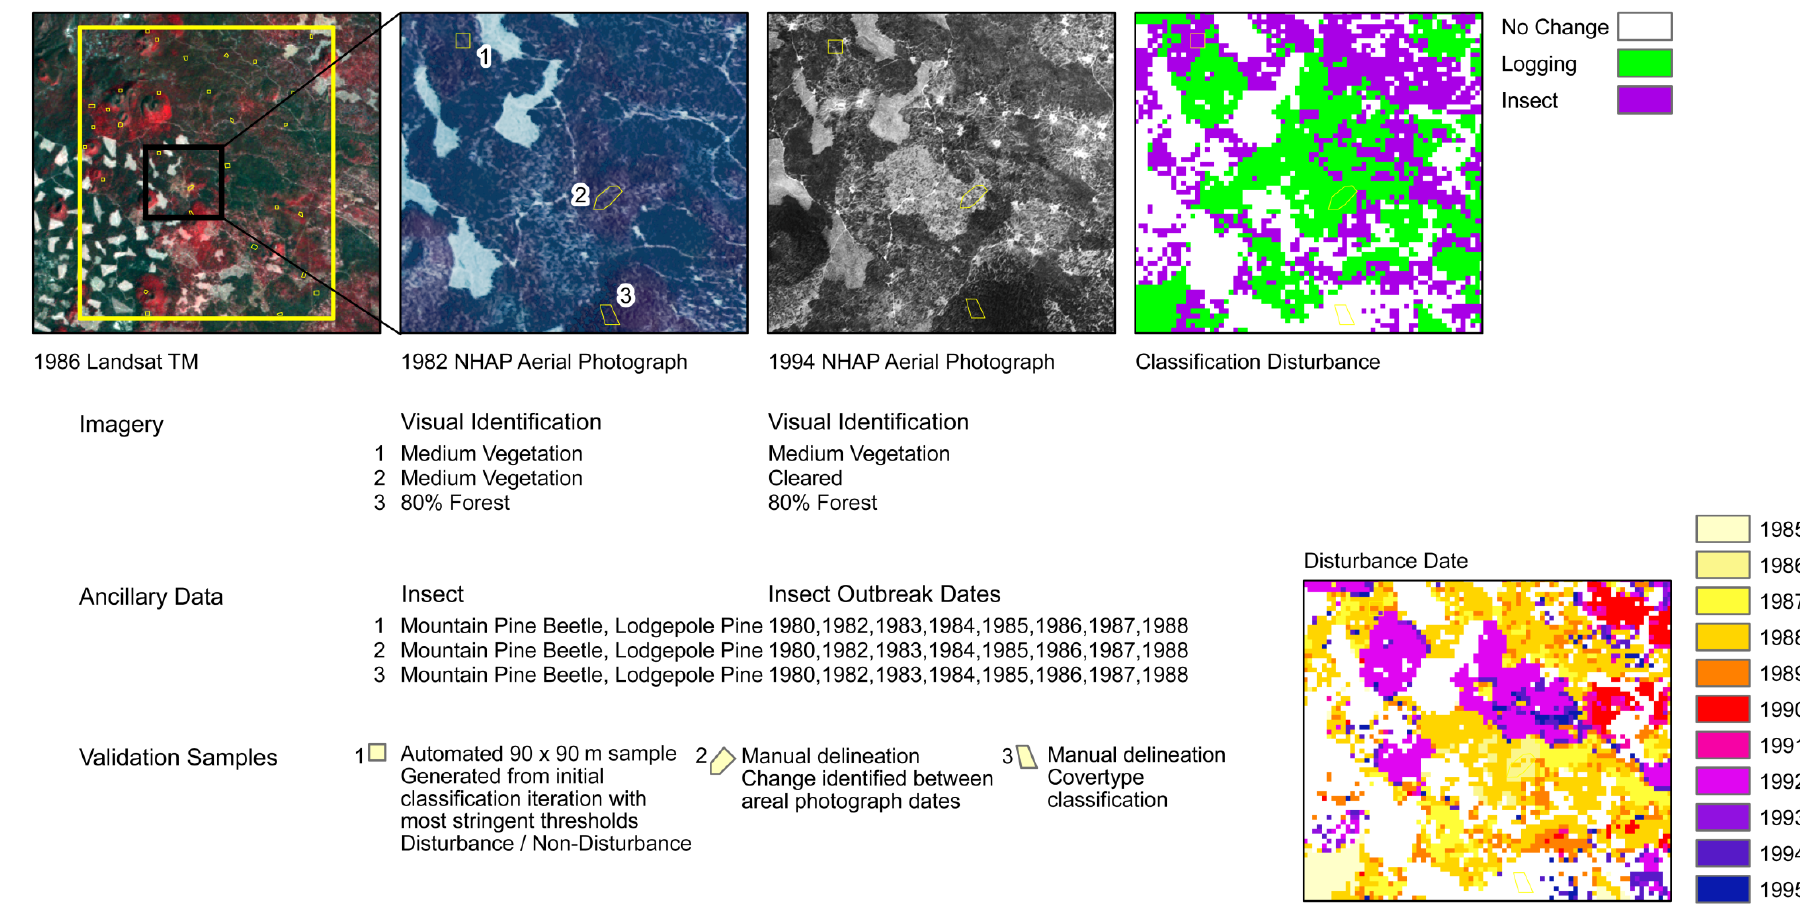
Figure 8. Example of classification evaluation with high-resolution air photo data and air survey data located in the orange box displayed in Figure